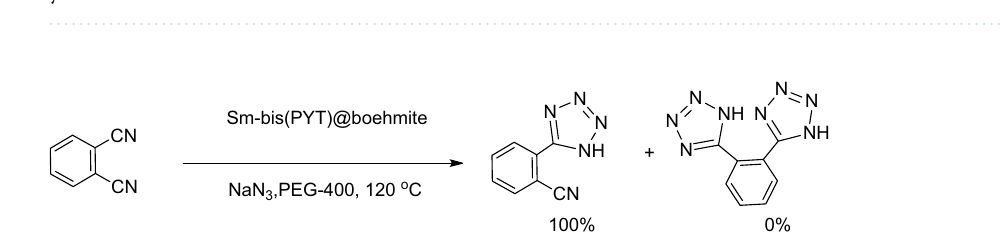
Table 5. Synthesis of 5-substituted 1H-tetrazole derivatives catalyzed by Sm-bis(PYT)@boehmite. a Isolated yield.